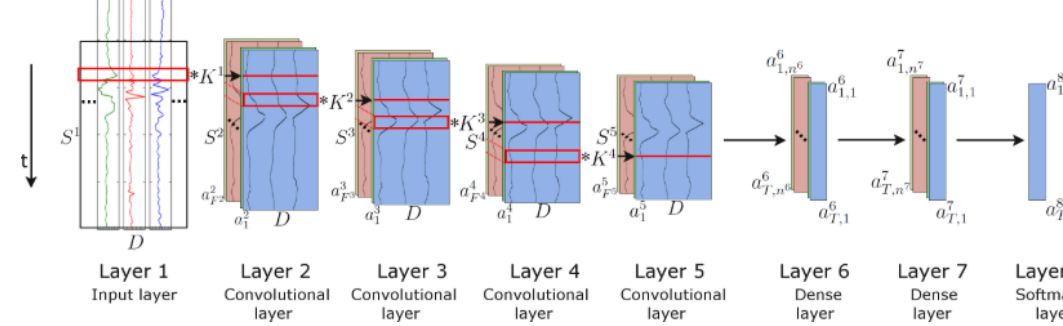
Figure 2. Architecture of the DeepConvLSTM framework used for activity recognition (after Ordóñez and Roggen,